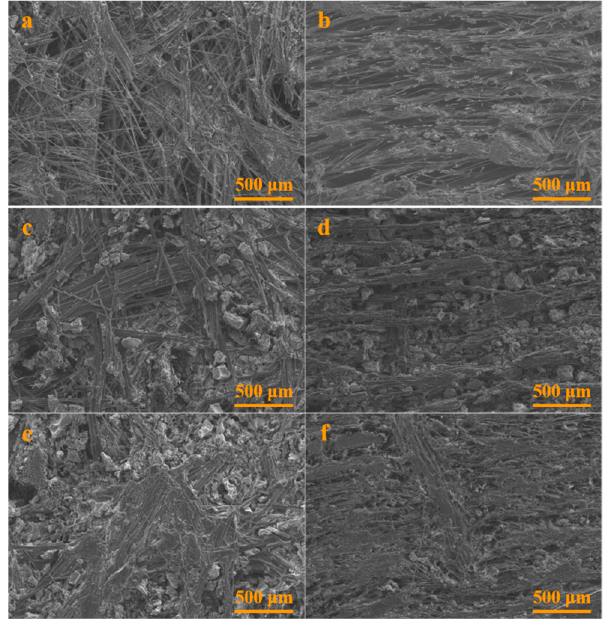
Figure 5. SEM images of as-prepared composites with different PIP cycle numbers from XY and Z directions: ( a , b ) one PIP cycle; ( c , d ) two PIP cycles; ( e , f ) three PIP cycles.